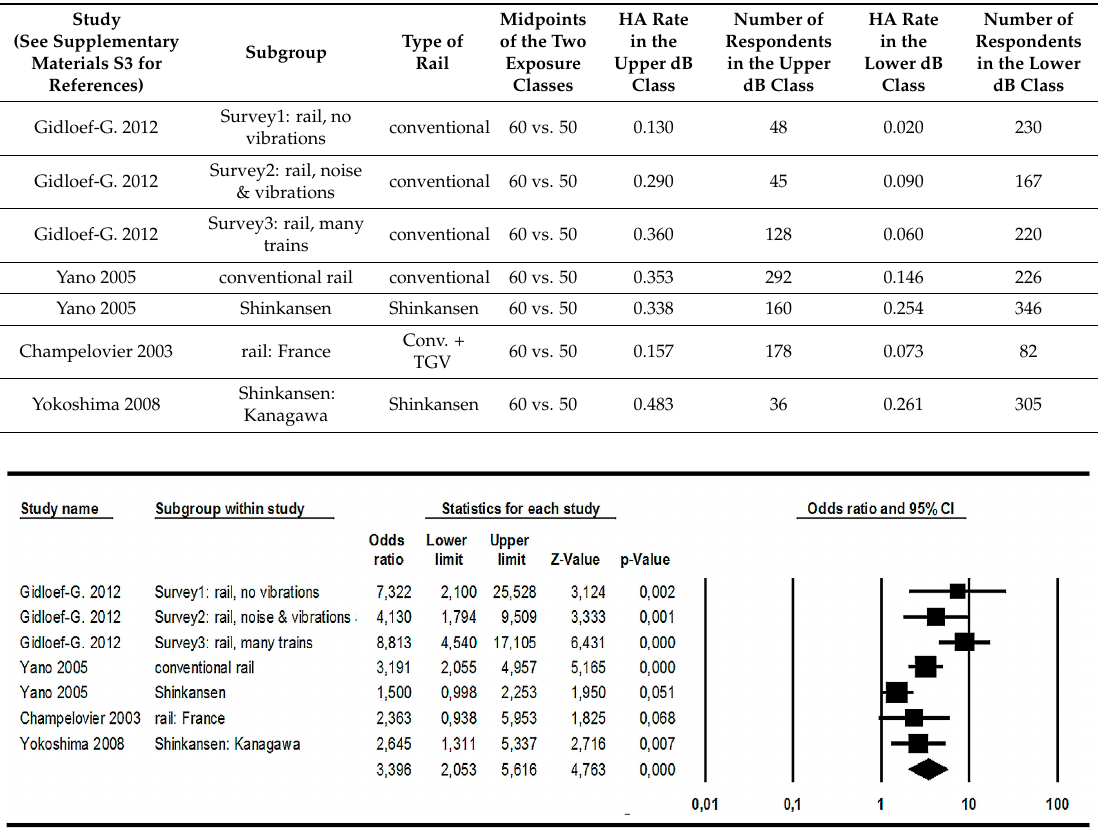
Figure 12. Odds Ratios and 95% confidence intervals from seven studies (based on observed data) for the increase of the rate of “highly annoyed” persons from 50 to 60 dB L Aeq,24h railway noise. The right part of the graph contains a forest plot of the ORs and their respective 95% confidence intervals. The figures of the last row indicate the summary estimates.